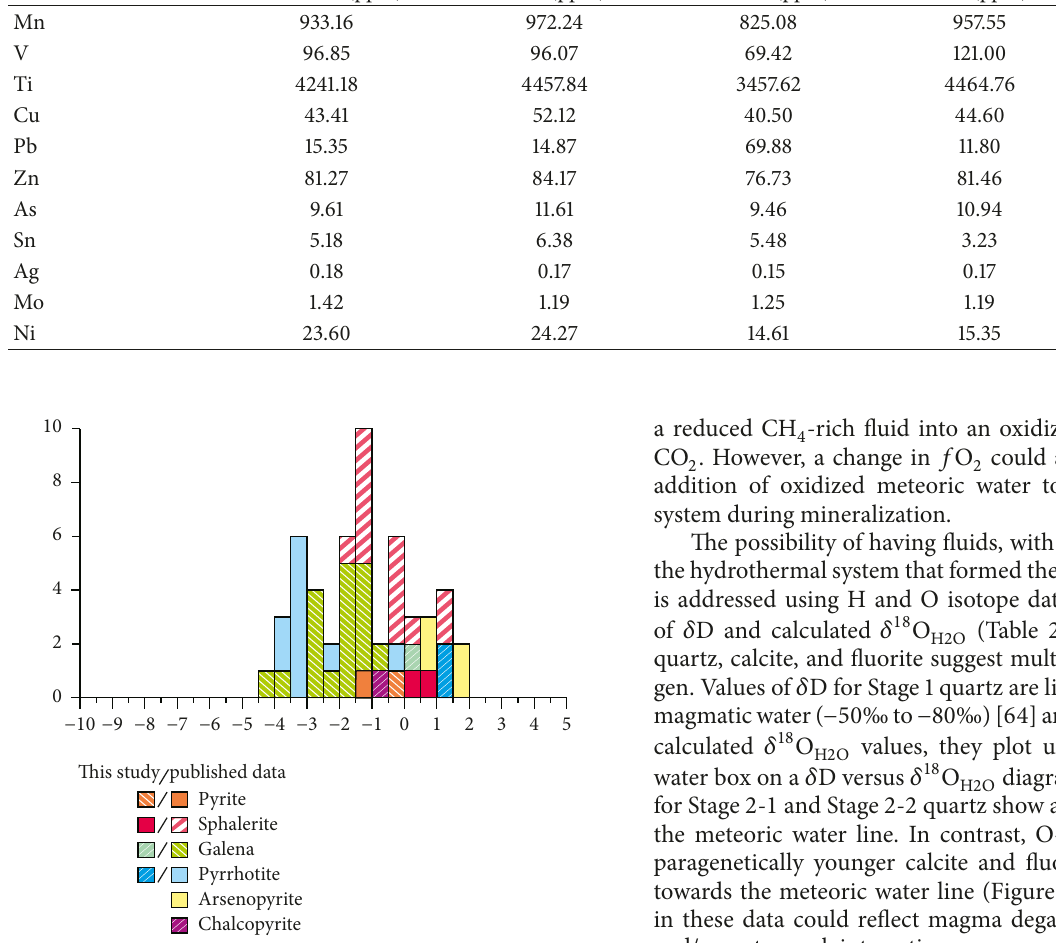
Figure 8: Histogram of S isotope data, Bairendaba Ag-Zn-Pb deposit. The published S isotope data are from Ouyang [33], Jiang et al. [17], and Mei et al.